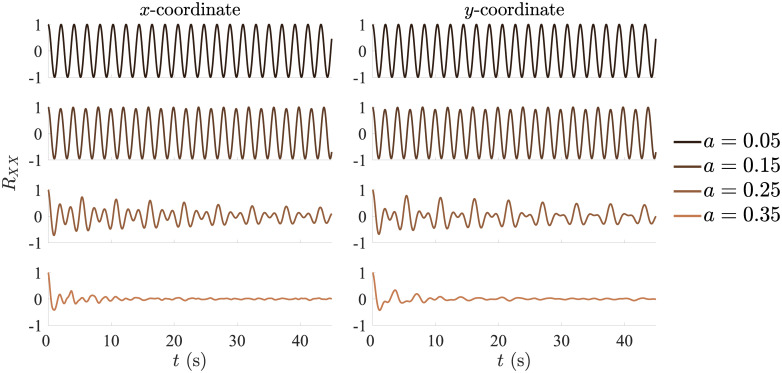
Autocorrelation functions for the target trajectory coordinates.The autocorrelation along x and y initially oscillates around ±1, decaying faster with increasing control parameter a, representing the loss of periodicity.